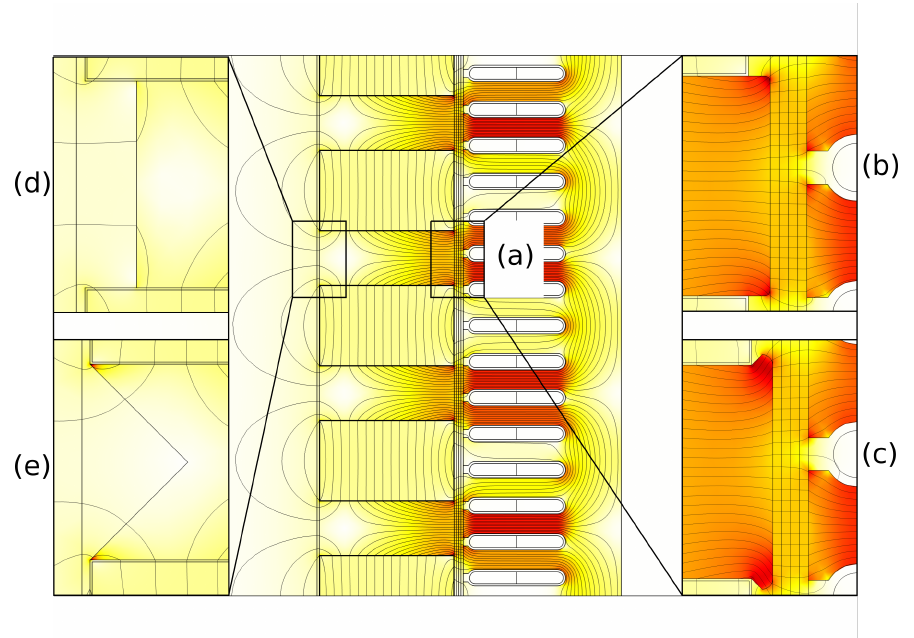
Figure 6. Different alterations to the linear electrical machine. The different design alterations from ( a – e ) are denoted Default, Normal, Tangential, Shortened and Triangular, respectively.